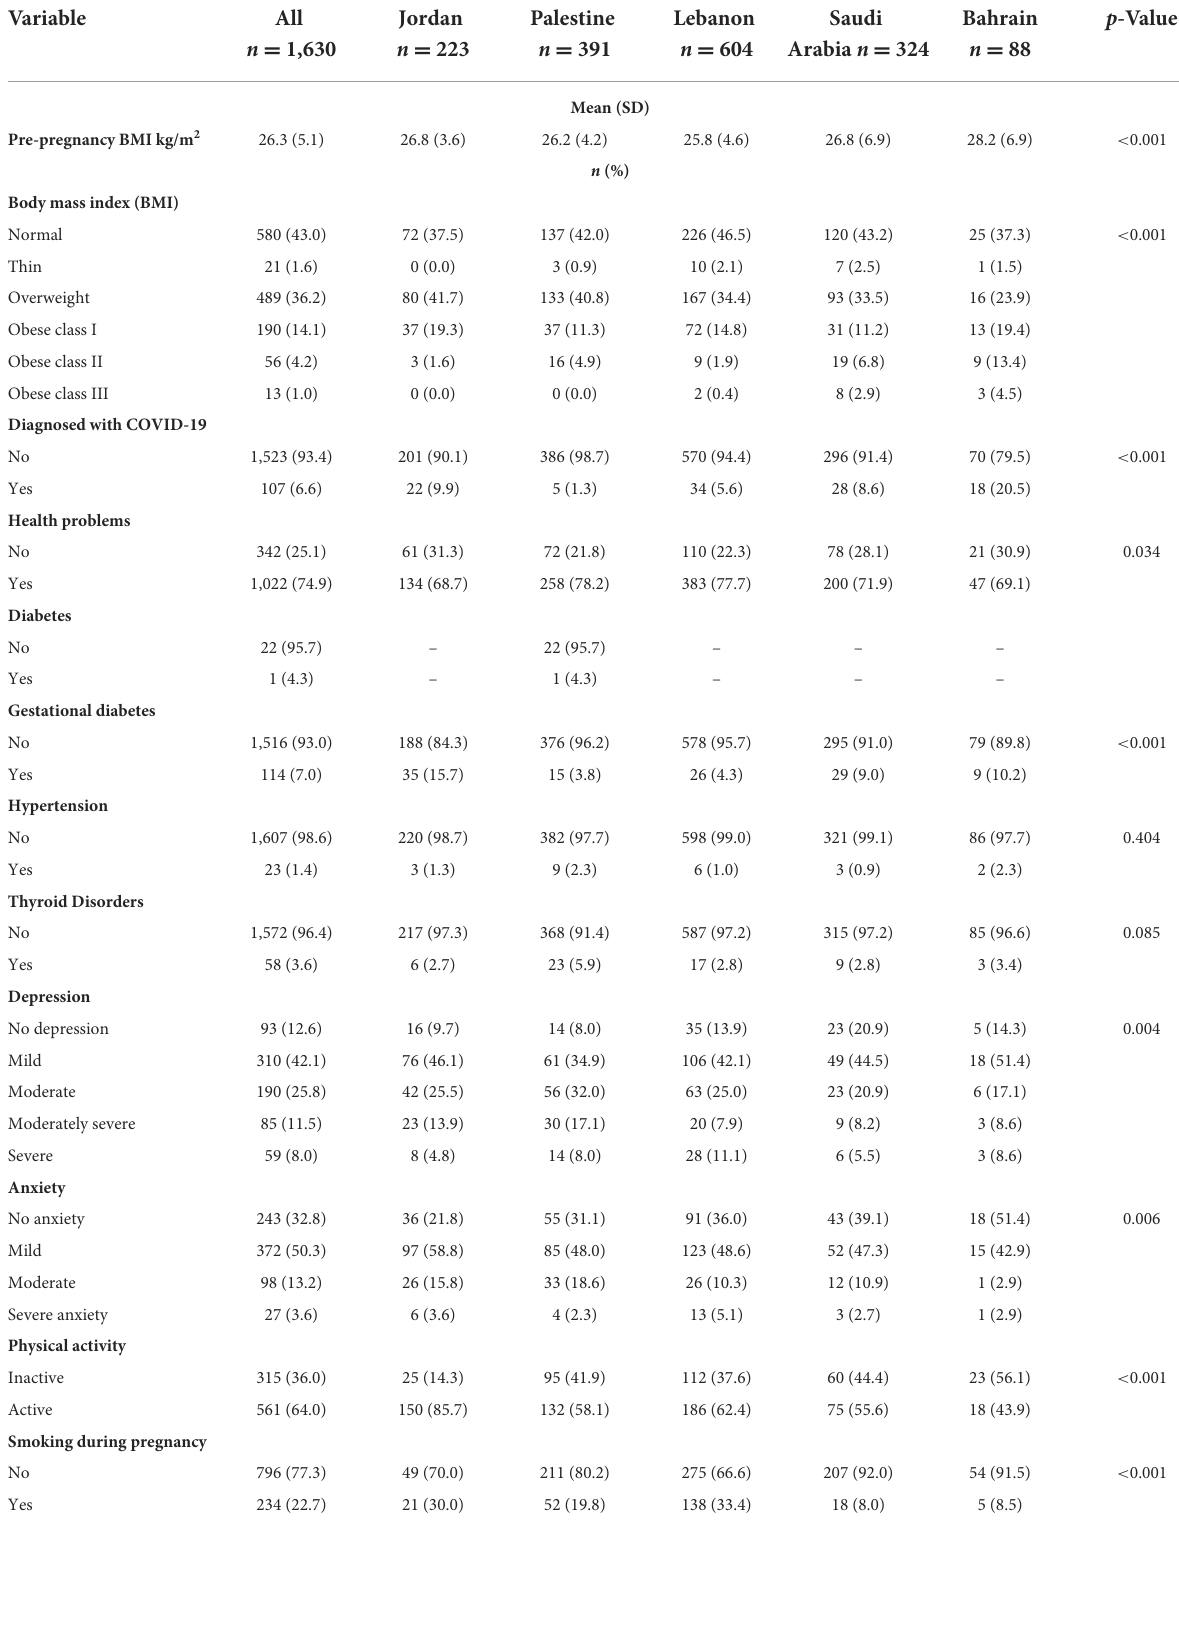
TABLE 2 Health related characteristics of the study postpartum women ( n =